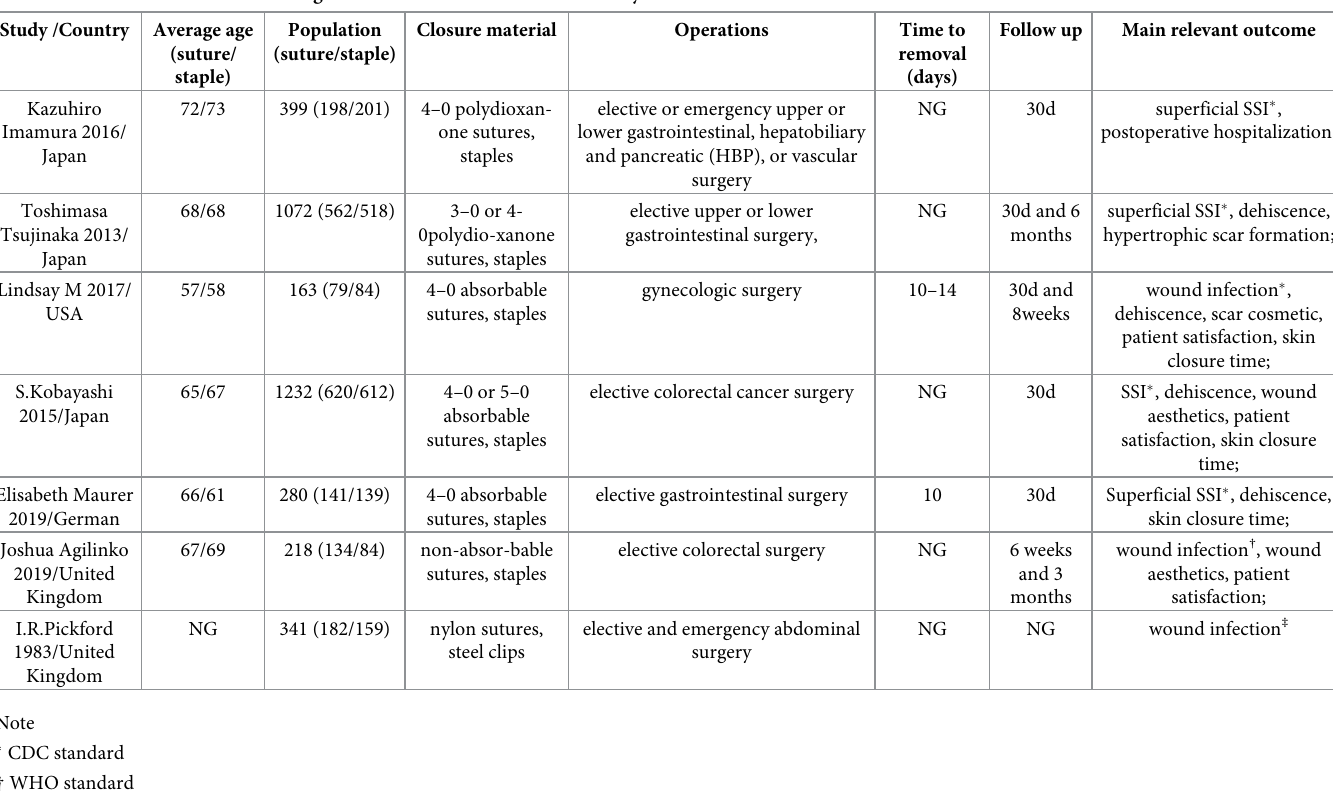
Table 1. Main characteristics of the eligible studies included in the meta-analysis. Study /Country Average age Population Closure material Operations Time to (suture/ (suture/staple) staple)